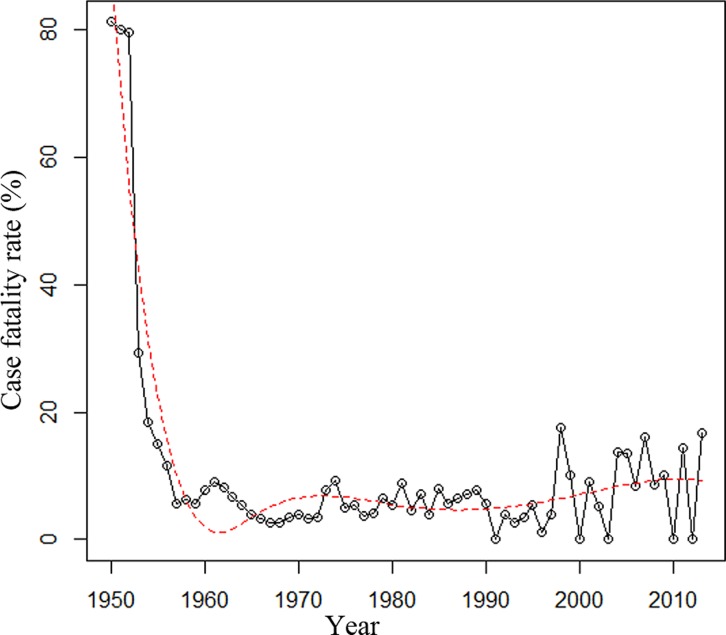
Case fatality rate of reported cases of meningococcal disease in Shanghai from 1950 to 2013.The trend was analyzed using regression splines (red dotted line).